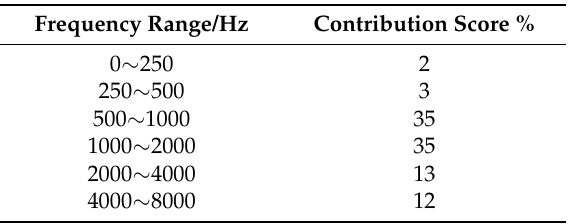
Table 4. The contribution of frequency components for speech